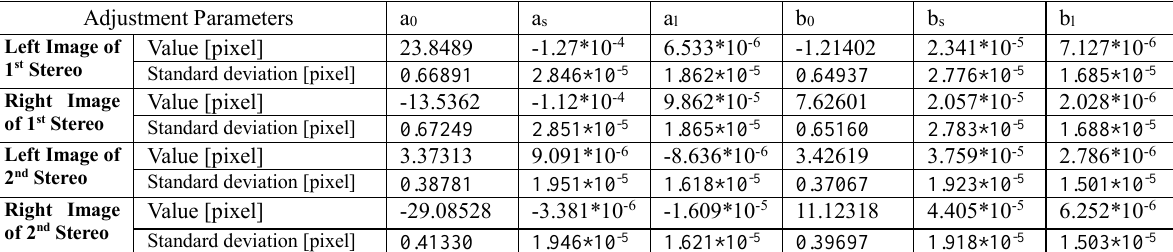
Table 1. Adjustment parameters of the WorldView-2 stereo